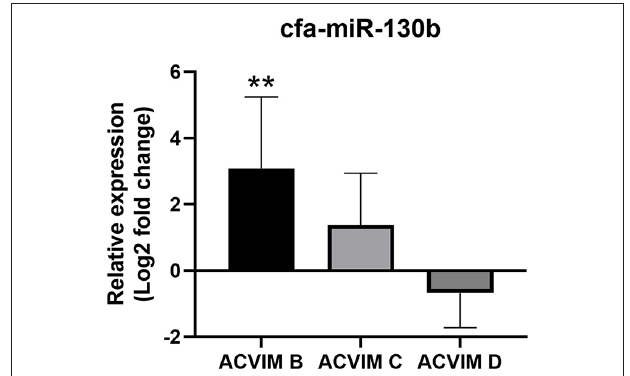
FIGURE 4 | Relative expression of cfa-miR-130b in MMVD group according to ACVIM stage. Data were presented as log2 transformed fold change relative to the healthy group (mean and standard deviation). The cfa-miR-130b was significantly upregulated in stage B while no statistical difference from healthy group was observed in stage C and D. ** p < 0.01, p -value adjusted by Dunn’s multiple comparison test. Only dogs in the MMVD group were assigned the ACVIM stage in this